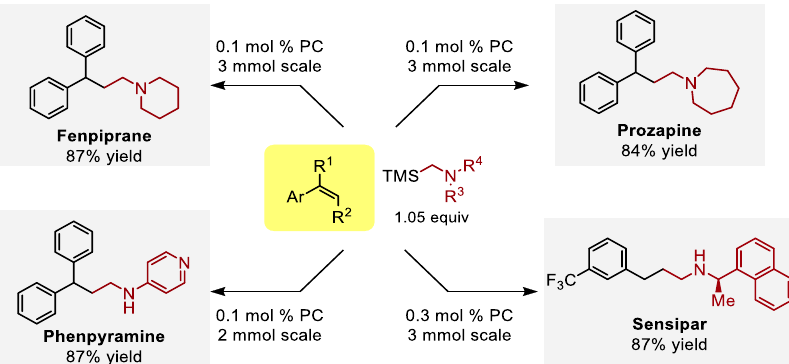
Fig. 5 Synthetic application hydroaminoalkylaltion of vinylarenes. Synthese of four bioactive molecules using this photoredox method with low catalyst loadings. PC [Ir(ppy) 2 (dtbbpy)]PF 6 (photocatalyst). See Supplementary Methods